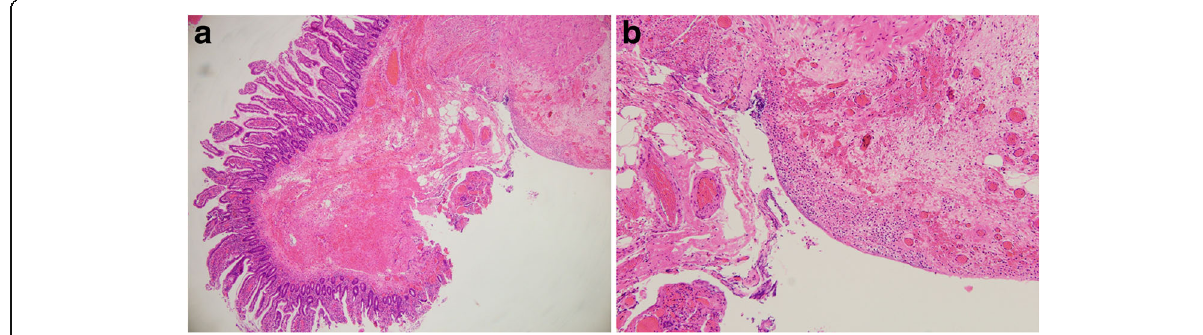
Fig. 2 Histopathological findings: histopathological examination results showing neutrophil infiltration and fibrinous deposits near the perforation. a High-power field. b Low-power field